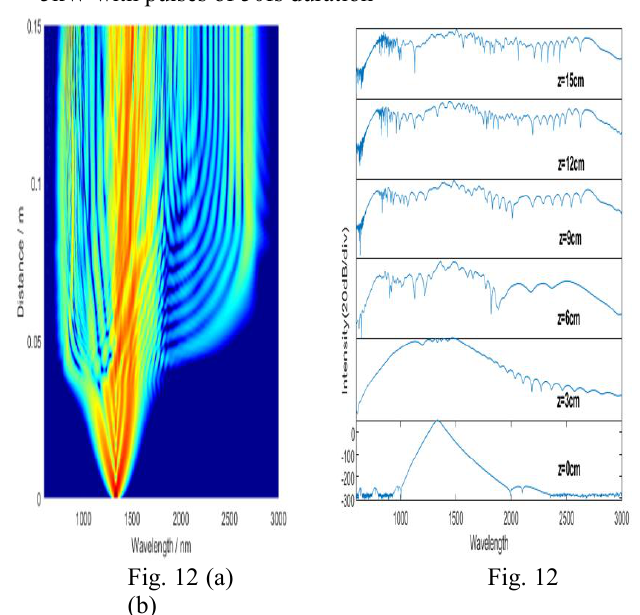
Figure 11: Density plot of spectral profile Fig. 11 (a) and Spectral profile Fig. 11(b) of supercontinuum generation of a 15cm long silica PCF at peak power of 5kW with pulses of 50fs duration